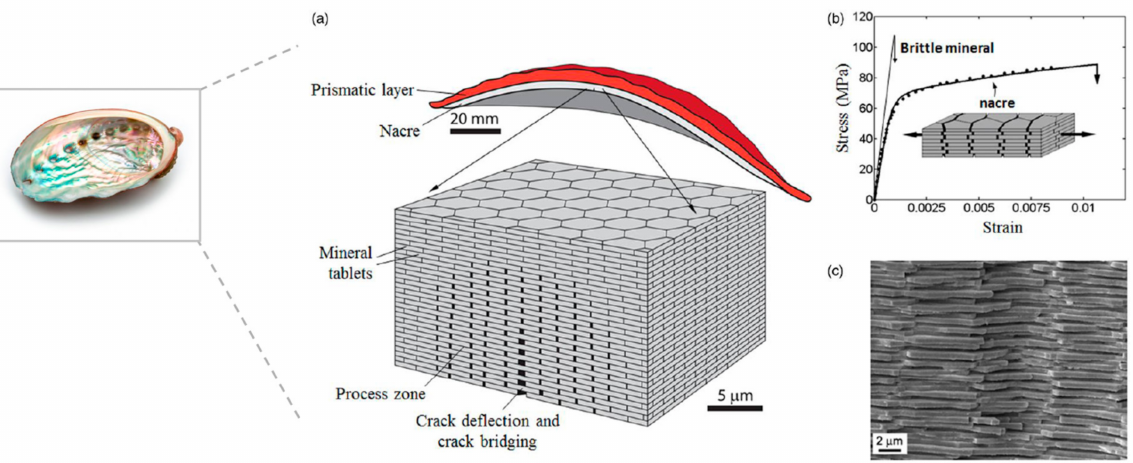
Figure 2. Nacre from mollusc shell ( a ) three-dimensional nanostructure of nacre organized in brick wall fashion, ( b ) tensile stress-strain curves for pure aragonite and nacre, ( c ) SEM image of the fracture surface of nacre with crack propagation deflected along the interfaces (reprinted with permission from Barthelat et al., 2015 [4]).